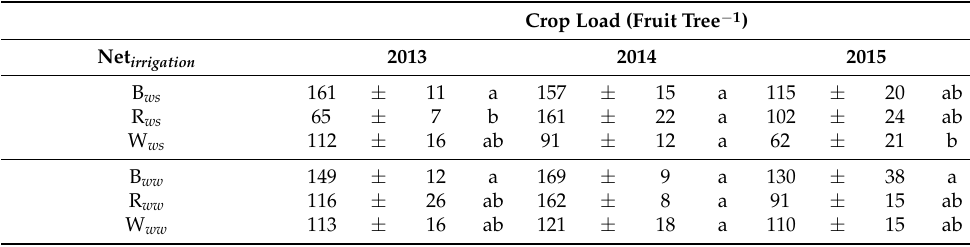
Table 1. Crop load determined at harvest (quantity of fruit per tree). Each output represents the mean value of 4 trees, followed by standard error and letters, indicating statistical significance at 95% when different, according to an SNK test.